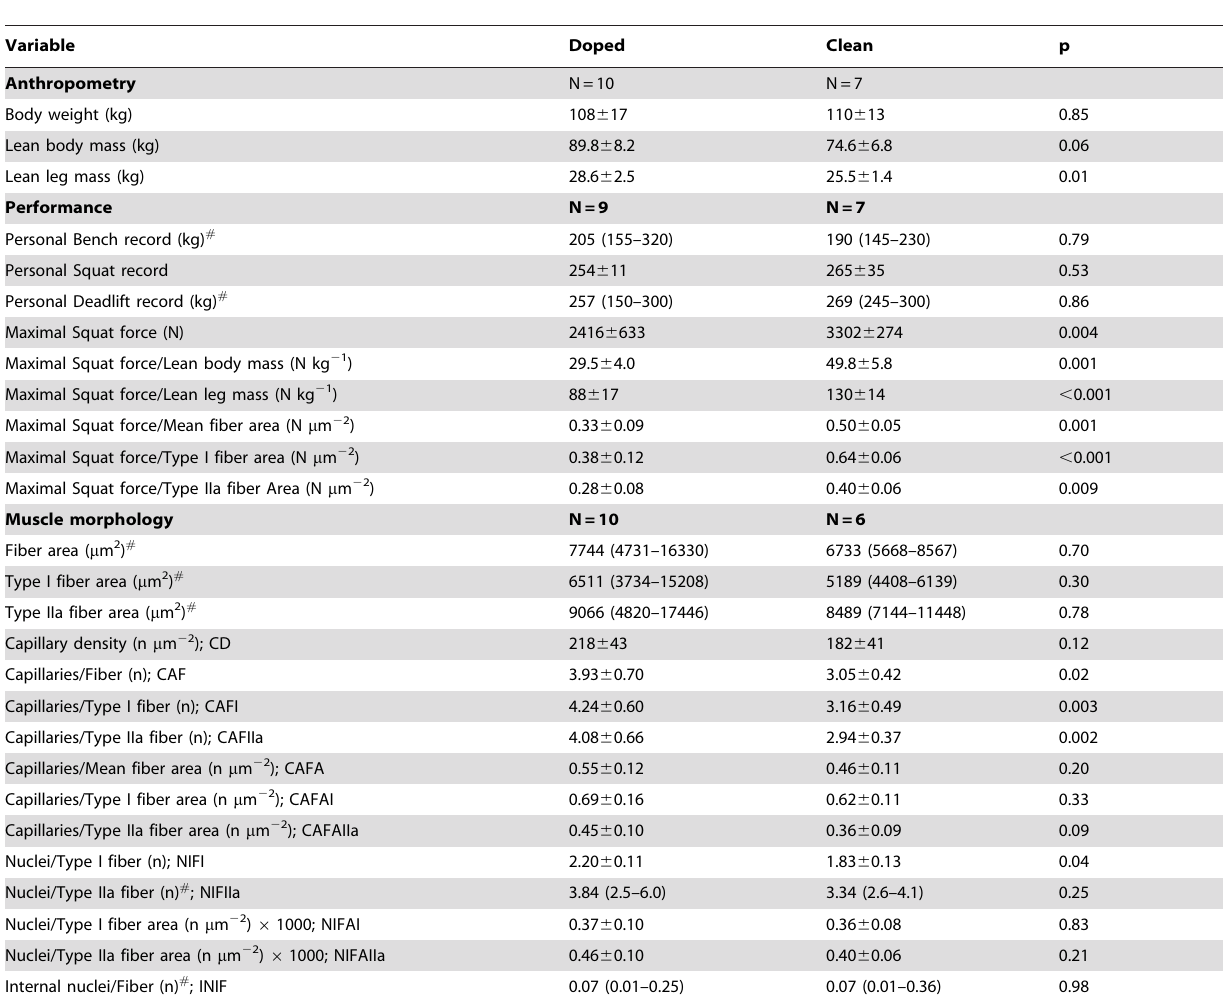
Table 2. Anthropometry, muscle strength and morphology in Clean and Doped athletes [mean 6 SD or median (min-max)].